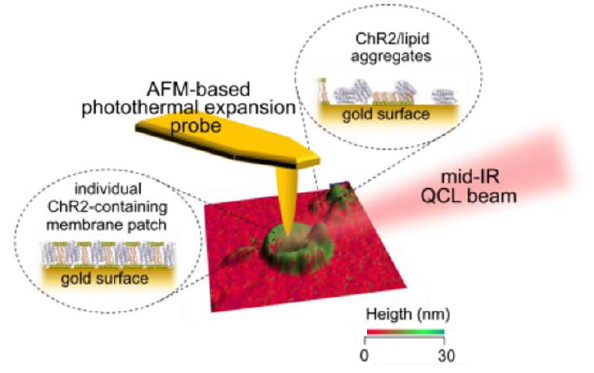
Fig. 1. Sketch of the AFM-IR setup based on a gold-coated tip probe and a mid-IR QCL laser beam. The AFM tip allows the topographic identification of a single membrane patch embedding ChR2 molecules, featuring a flat top surface and a height of ≈ 7